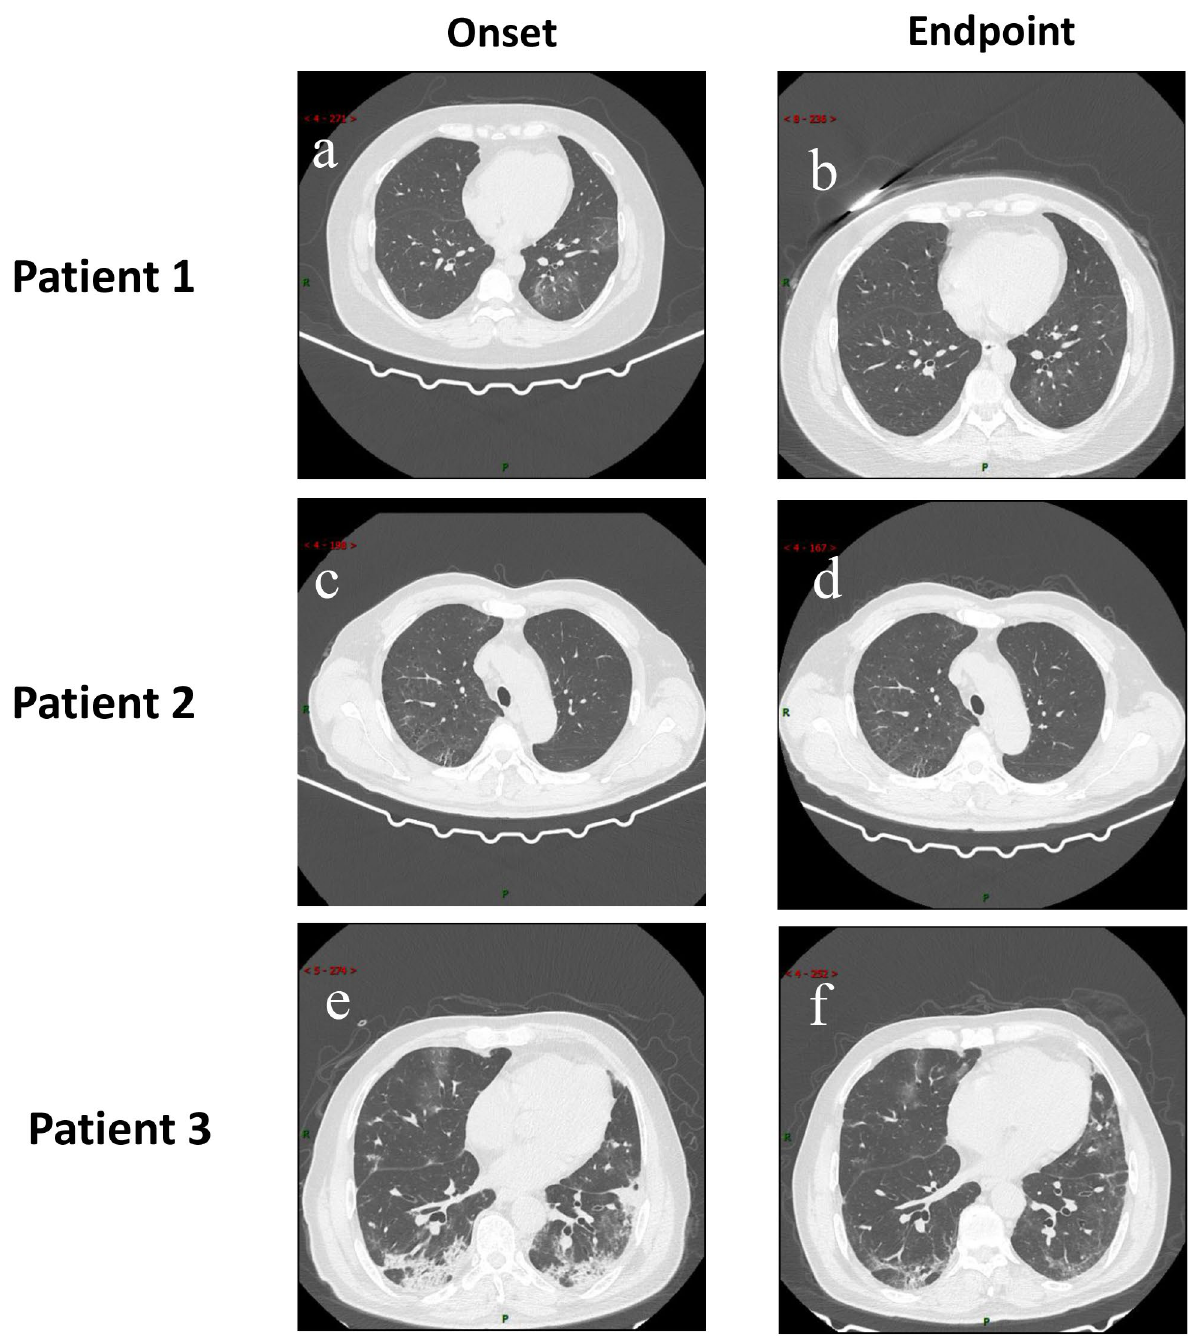
Figure 1. Representative chest CT images. ( a ) Ground-glass opacities in the dorsal segment of the left lower lobe of lung were seen in a 44-year-old female on admission, and partial absorption of lung lesions before discharge ( b ), Multiple fibrotic stripes shadows in dorsal segment of the lower lobe of the right lung were seen in a 62-year-old male after symptom onset ( c ), however, no obvious changes were observed before discharge ( d , e ), multiple fibrotic stripes shadows and patchy dense shadow (exudative lesion) were shown in a 65-year-old severe male on admission. ( f ) The exudative lesions were less and the fibrosis lesions were more than before in 20 days after